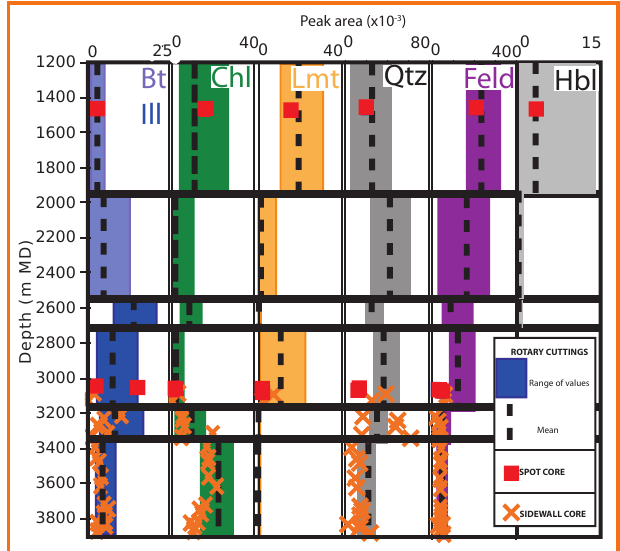
Figure 3. Major mineralogical zones of the SAFOD main hole as defined by XRD analyses of rotary cuttings. The mineralogies of spot and side wall cores are also shown.